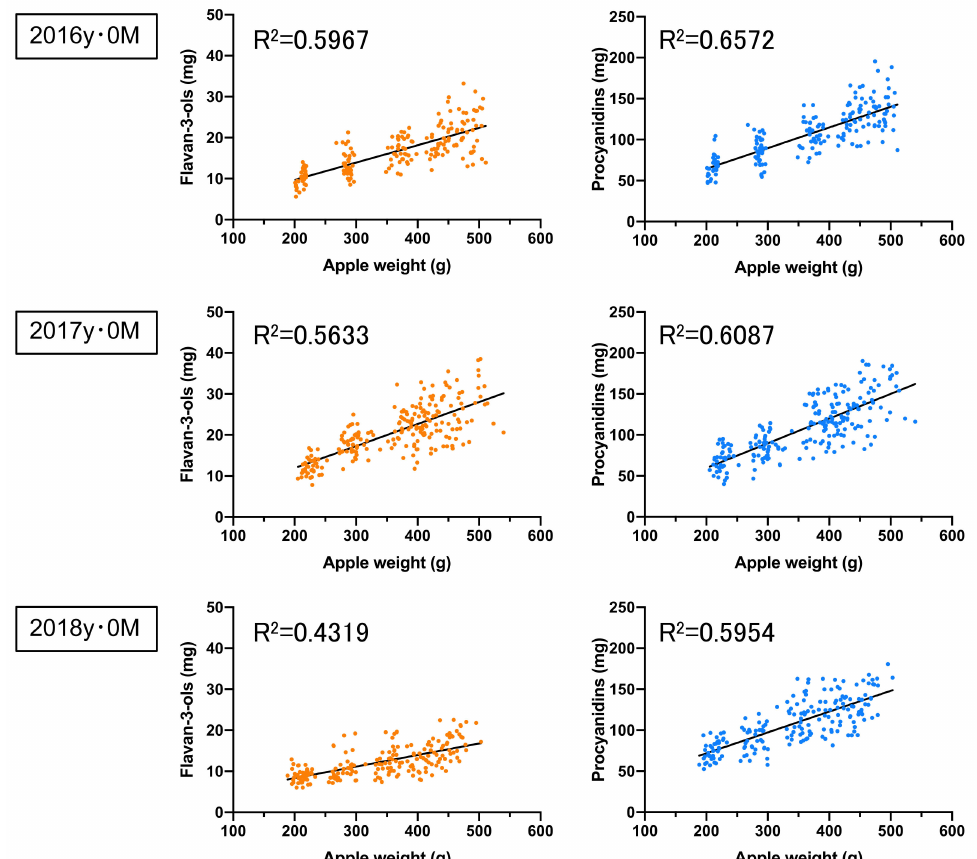
Figure 2. The correlations between the apple weights and both the flavan-3-ol and the procyanidin concentrations in the non-bagged ‘Fuji’ apples. The apples were analysed in 2016y · 0M ( n = 196), 2017y · 0M ( n = 219), and 2018y · 0M ( n = 194), where y refers to the year, M refers to the month, and n refers to the number of